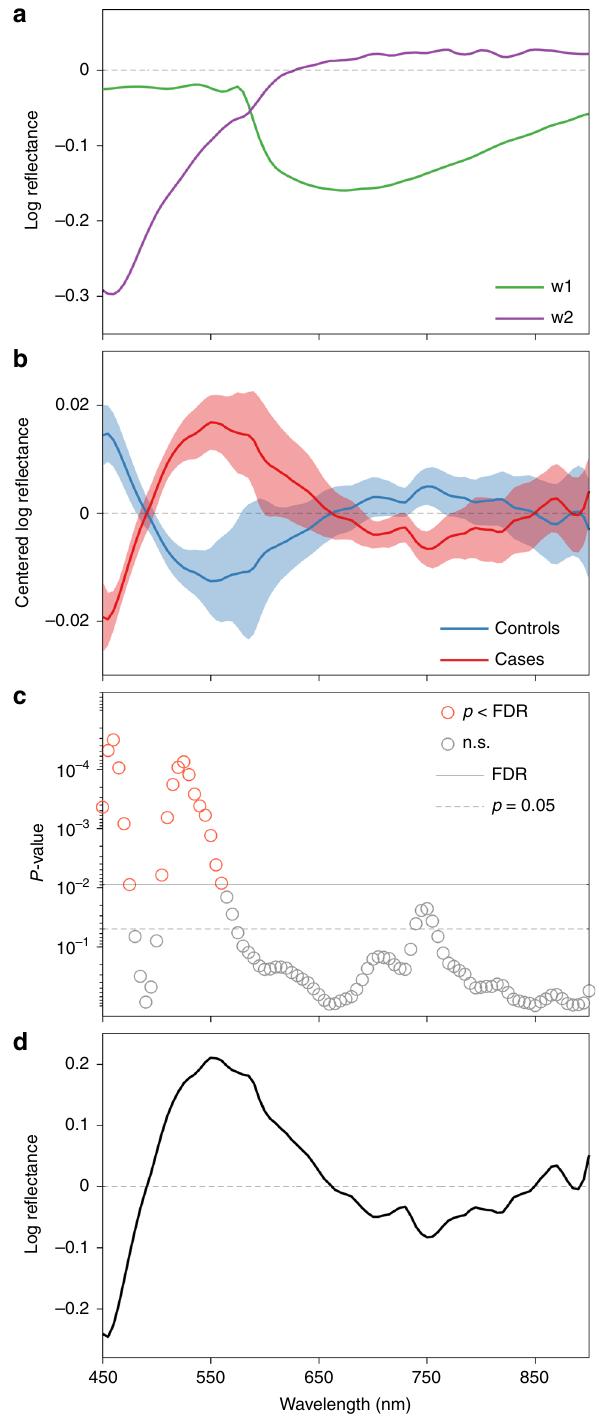
Fig. 3 Identifying a spectral difference between groups. a Estimation of two main spectral components of within-subject variability (w1, green and w2, purple). These components were largely explained by a combination of spectra of known ocular constituents and were used to correct each re fl ectance spectrum. b Corrected re fl ectance spectra at sampling location S1 ( n = 20 controls, n = 15 cases, data shown as mean ± SEM) revealed a spectral difference between the two groups. c P values for two-sided unpaired t tests between groups using false discovery rate (FDR) control for signi fi cance across all the wavelengths (n.s. is for non-signi fi cant). d Spectral model at sampling location S1 corresponding to the main spectral difference between the two